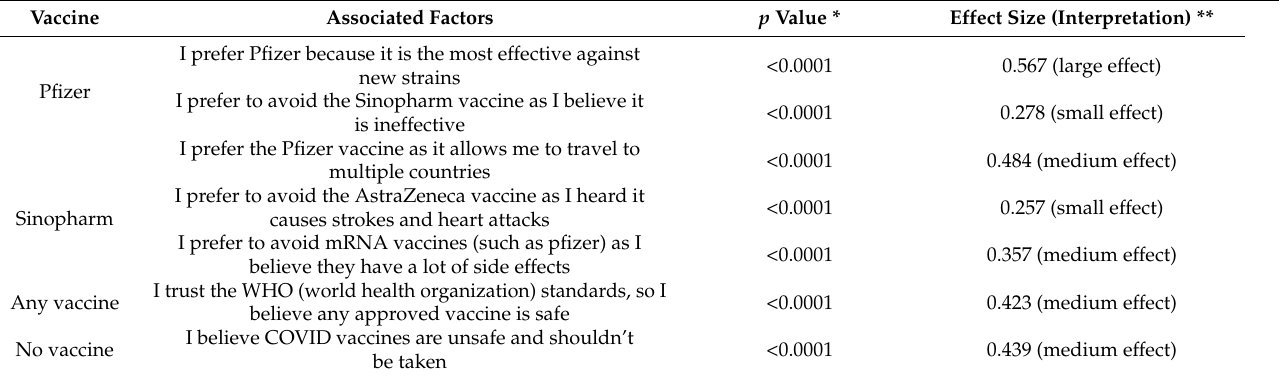
Table 3. Factors affecting vaccine